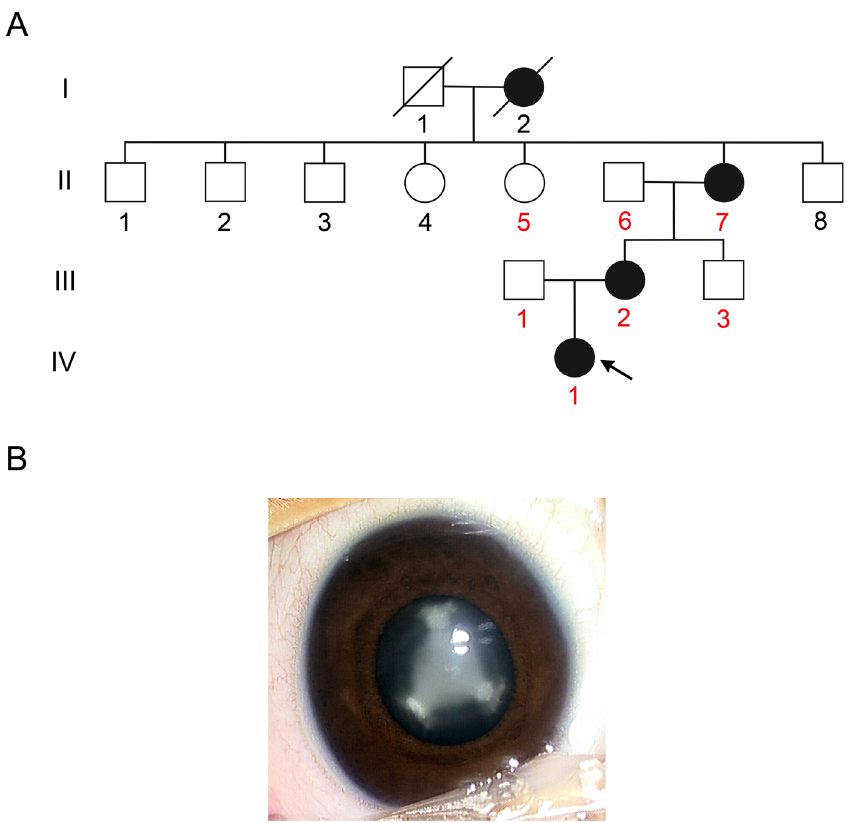
Fig 1. The family with congenital nuclear cataract. (A) Pedigree of the Chinese family with autosomal dominant nuclear cataract. Squares and circles indicate males and females, respectively. Black symbols represent individuals with a cataract phenotype and open symbols represent unaffected individuals. The proband is marked by an arrow. The numbers of the participants in this study are indicated by red color. (B) Lens picture from the proband showed the opacities located in the lens nucleus and that the sutures were also involved (right eye).